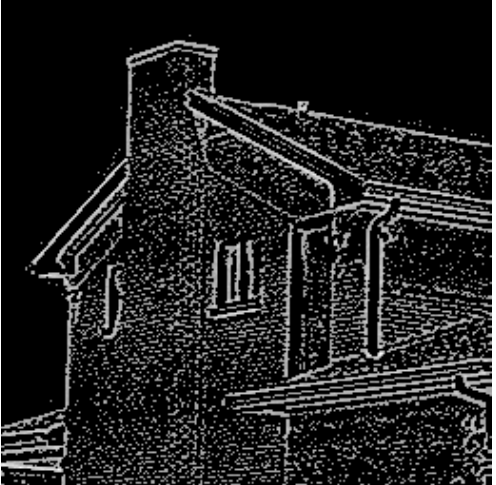
Figure 8. The resultant image (258 × 258 pixels) with Coiflet, j = 1, Λ =